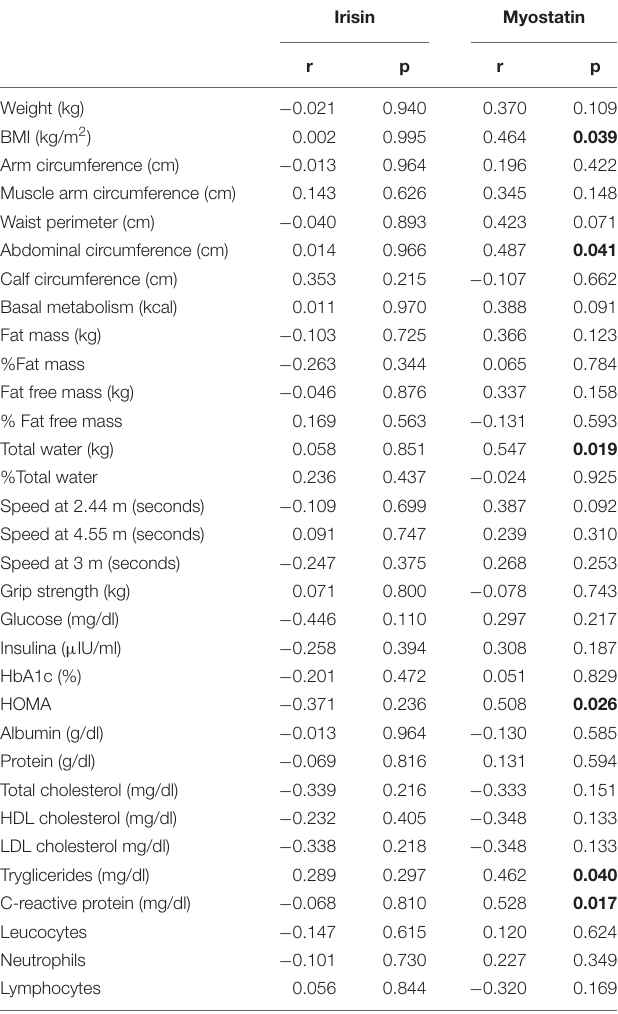
TABLE 6 | Bivariate correlations between anthropometrical and clinical parameters and circulating irisin and myostatin in control group at follow-up.